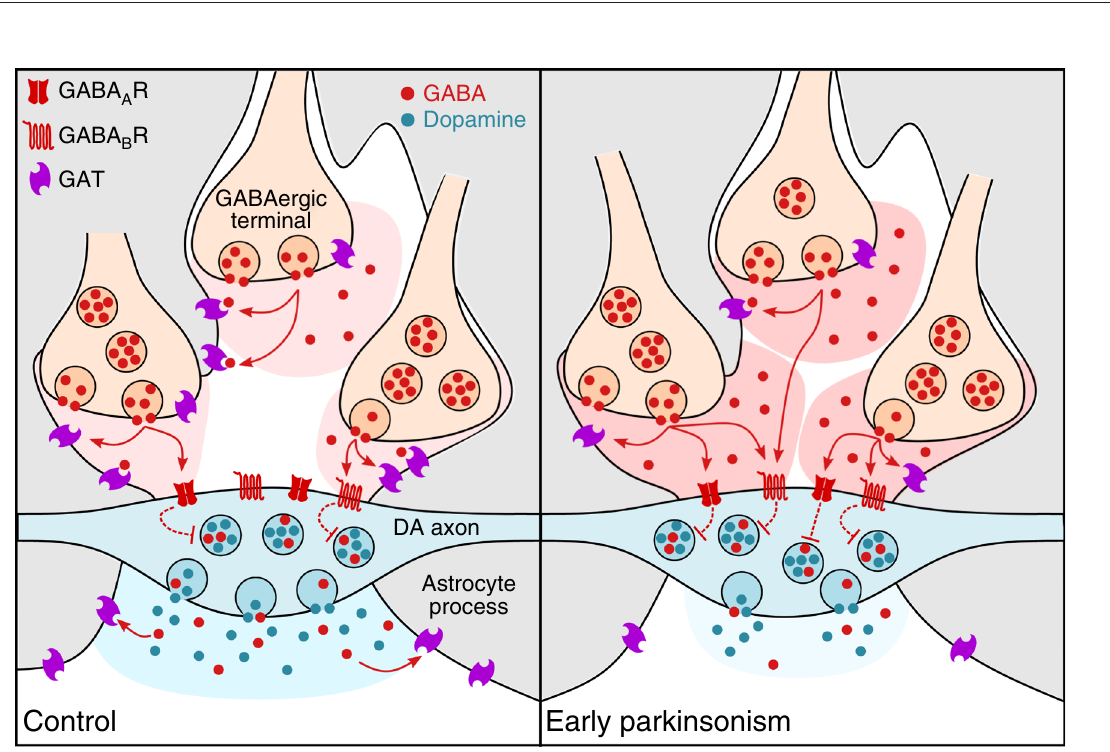
Fig. 9 Augmented tonic inhibition of striatal DA release in dorsal striatum in early parkinsonism due to reduced striatal GAT expression. Under normal circumstances (left), GAD-synthesized GABA released from GABAergic striatal neurons can spillover to act at GABA receptors (GABA A R and GABA B R) located presumably on DA axons, inhibiting (dashed red lines) DA and GABA co-release. The level of GABA spillover and tonic inhibition of DA release is determined by the activity of GABA transporters (GATs) located on astrocytes (grey) and neurons, which remove GABA from the extracellular space. In a mouse model of early parkinsonism (right), striatal GAT expression is downregulated in dorsal striatum, resulting in augmented tonic inhibition of DA release by GABA. Co-release of GABA from DA axons is also